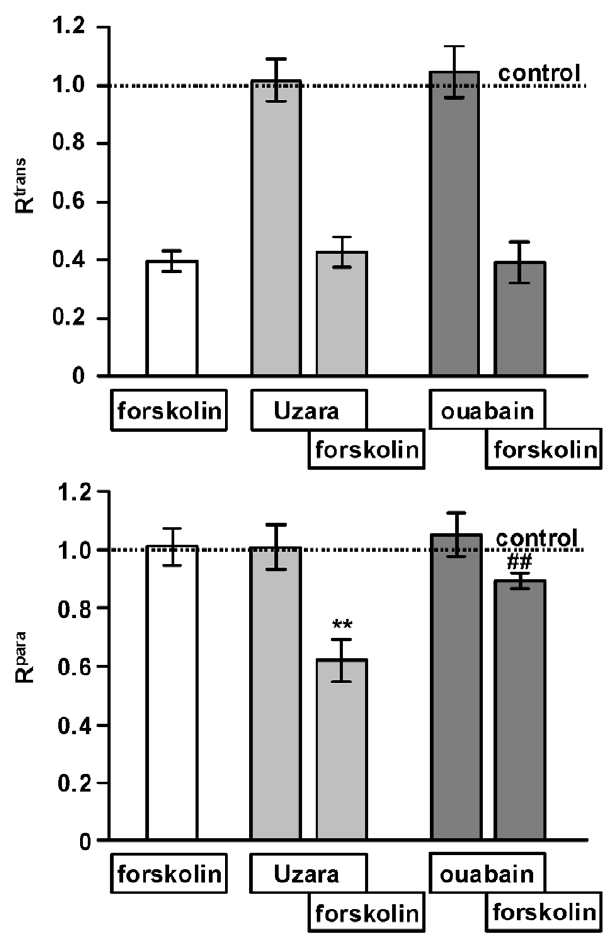
Figure 6. Effects of Uzara, ouabain and forskolin on R para and R trans in HT-29/B6 cells. The influence of Uzara and ouabain on R para and R trans with and without forskolin was determined by two-path impedance spectroscopy in HT-29/B6 cell monolayers mounted in Ussing chambers. Forskolin reduced R trans , whereas R para remained unaltered. The co-incubation of Uzara with forskolin caused no change of R trans compared to forskolin alone, whereas R para was clearly reduced in the co-incubation group. Similarly, compared to forskolin alone, ouabain together with forskolin had no effect on R trans . The slight reduction of R para observed under these conditions did not reach significance. Data are expressed as mean 6 s.e.m. (n=5-6). Untreated control values set as 1. Asterisk indicates a difference compared to